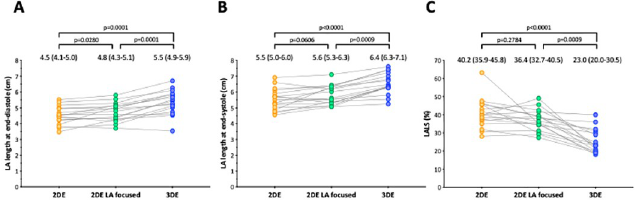
Fig 8. Comparison of LA length and strain among standard 2D images, LA focused 2D images, and 3D echocardiography. Values are expressed as medians and (interquartile ranges).